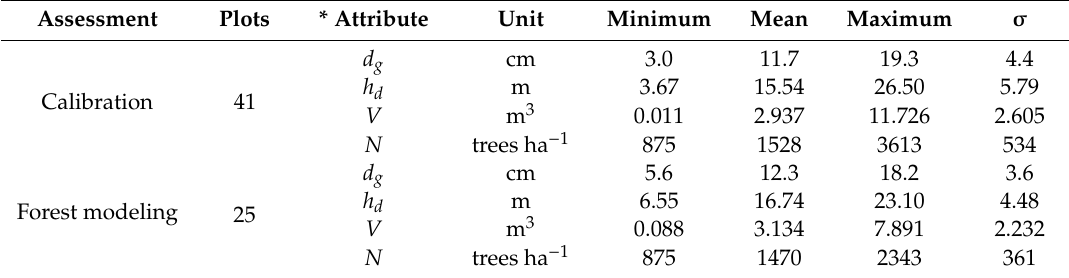
Table 1. Biometrical description of the forest within plots with their minimum, mean, maximum and standard deviation ( σ )